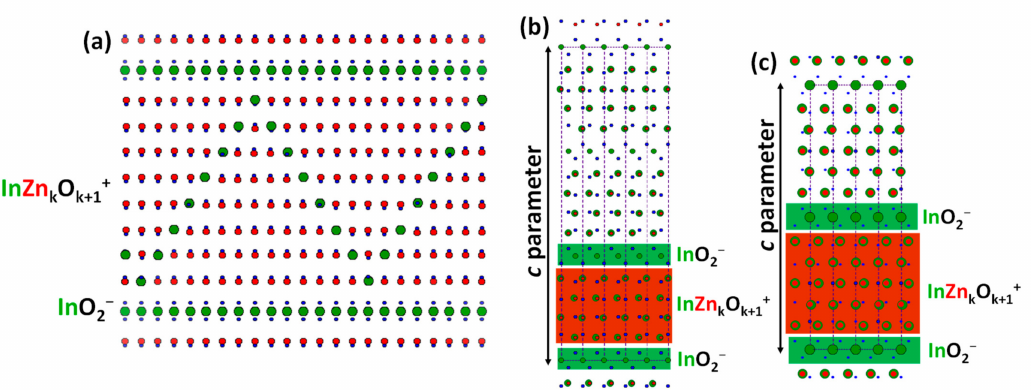
Figure 1. ( a ) Schematic structural model for k = 7 along the [110] direction. Schematic structural model for ( b ) k = 3 and ( c ) k = 4 along the [010] direction. Indium, zinc and oxygen atoms are represented in green, red, and blue,